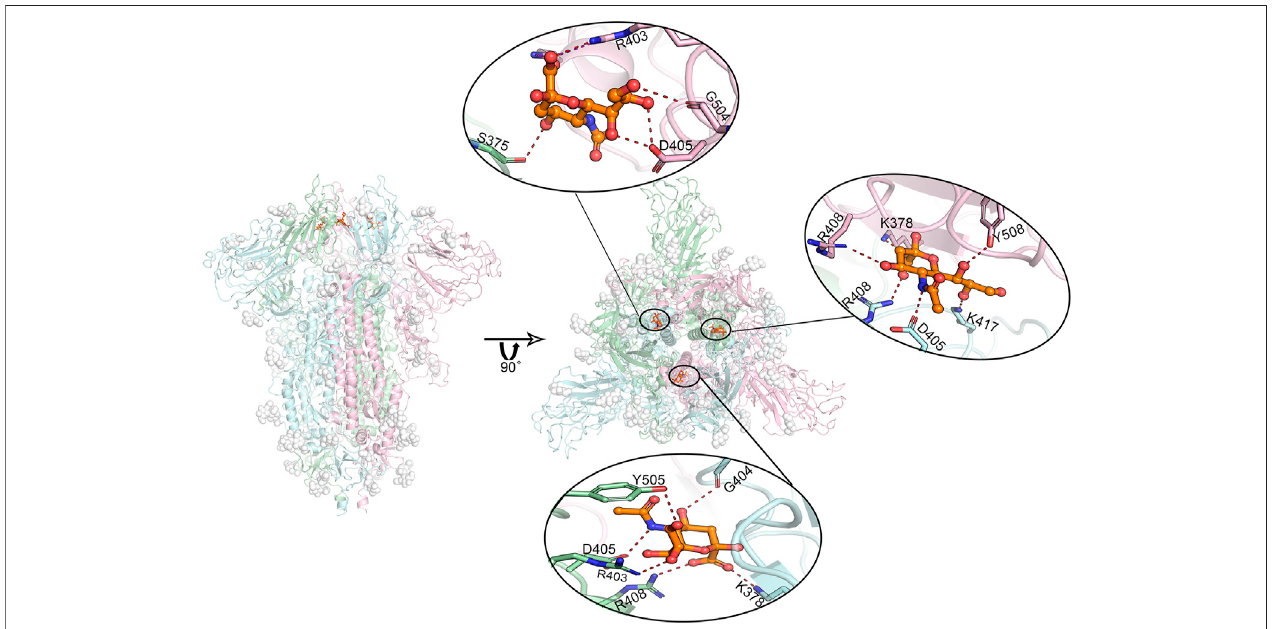
FIGURE 4 | Predicted most likely binding modes of sialic acids with glycosylated spike protein at positions SA_6, SA_7, and SA_24. Molecular dynamics simulationsidenti fi edthreestableinteractingsites,locatingbetweeneverytwoadjacentRBDdomains.The fi gureinthemiddleshowstherelativepositionsofthesethree bound sialic acids. The enlarged binding areas show the detailed molecular interactions at each binding site. Position SA_6 is between chain B (pale-cyan) and chain C (light-pink). Sialic acid can form hydrogen bonds with the residues of R403, G504 as well as D405 from chain B, and the residue of S375 from chain C. Position SA_7 locates between chain A (pale-green) and chain B, where the sialic acid molecule is observed to speci fi cally interact with the residues of R403, D405, R408 and Y505 of chain A, and the residues of K378 as well as G404 of chain B in the form of salt bridges or hydrogen bonds. Position SA_24 lies between chain A and chain C, wherethesialic acidbindstotheresidues ofD405, R408asK417ofchainB, and theresidues ofK378, R408,and Y508ofchainC. Overall, theresidue D405ineach of these three chains shows a signi fi cant role in sialic acid binding. The interactions to K378/S375 on their adjacent chains may play a role in further stabilizing sialic acid